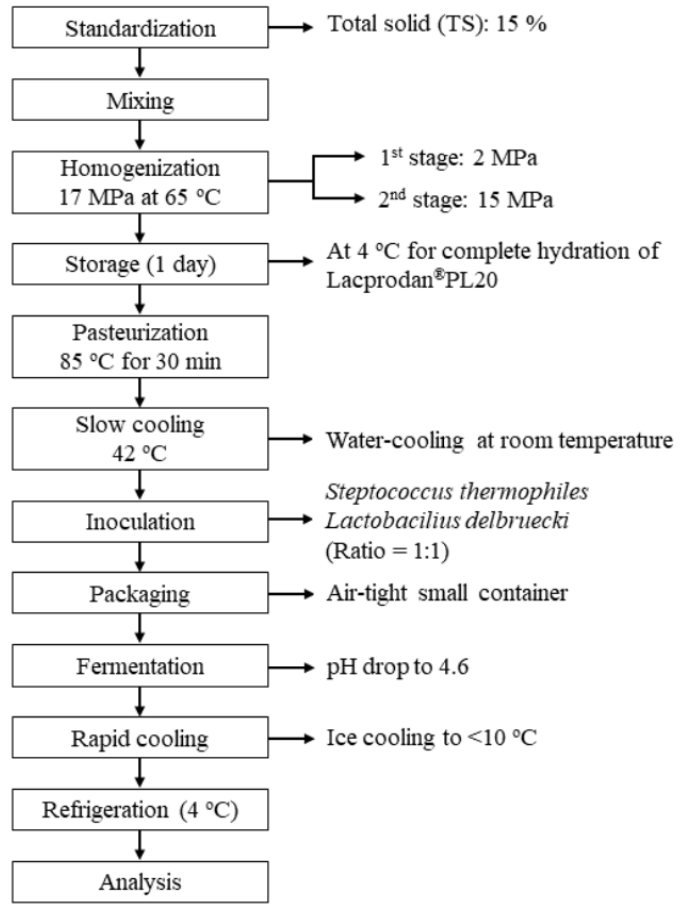
Figure 1. Schematic diagram of set yogurt preparation using two-stage homogenization.